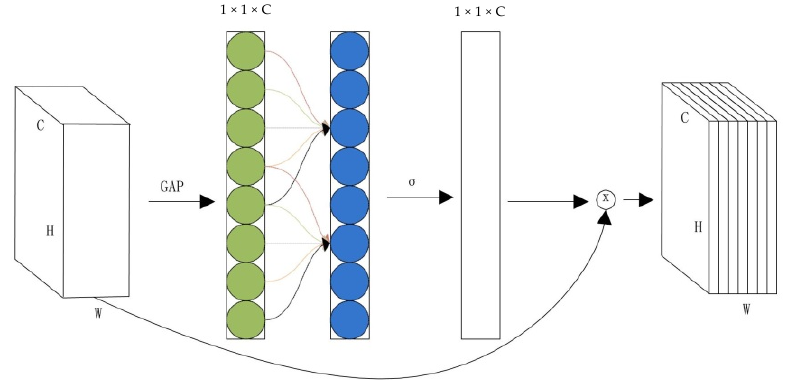
Figure 8. ECA module.